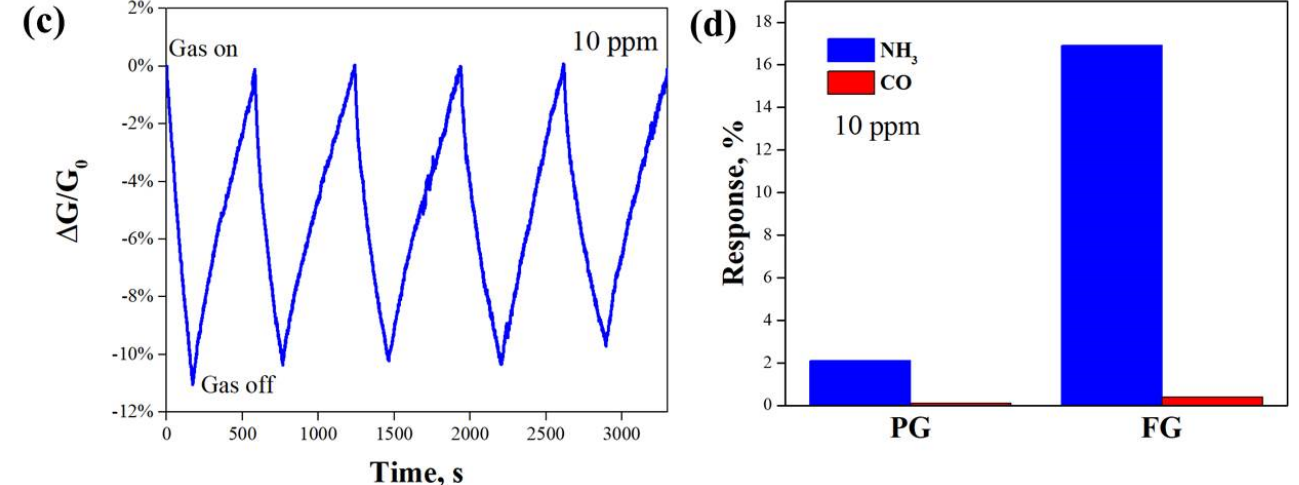
Figure 2. ( a ) Responses of PG, DG and FG to 10 ppm NH 3 with the same exposure time. ( b ) Responses of FG devices under different concentration of NH 3 gas under ambient pressure. ( c ) Repeatability of the FG device to 10 ppm of NH3 gas. ( d ) Responses of the PG and FG sensors to NH 3 and CO gases with a concentration of 10 ppm.